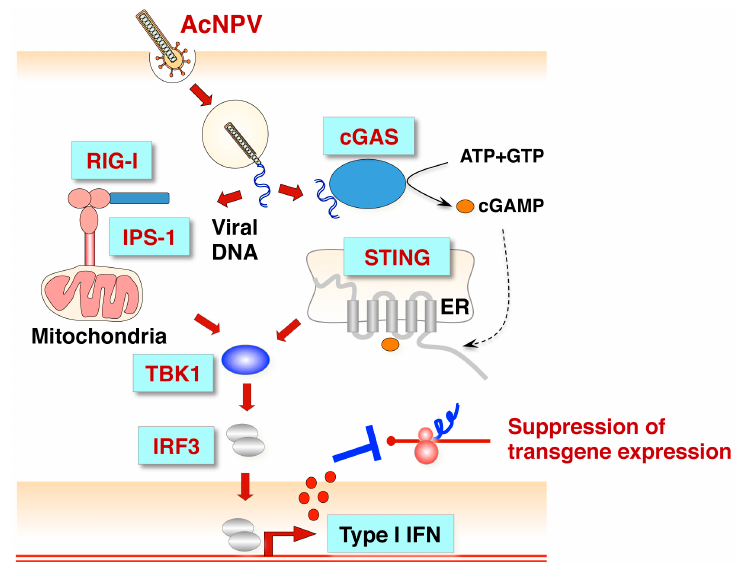
Figure 3. Innate immune response against baculovirus infection in mammalian non-immune cells.